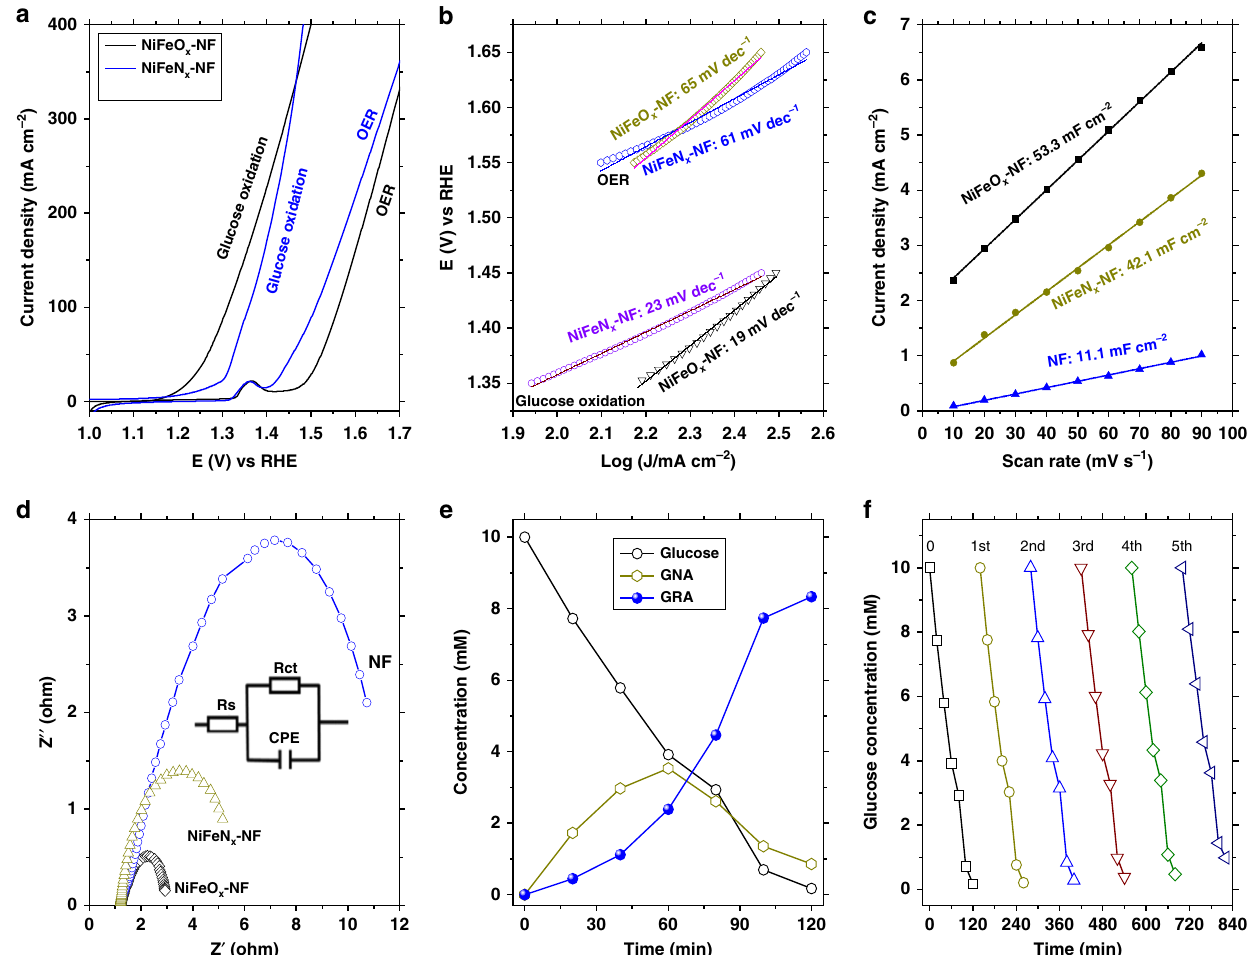
Fig. 4 Anodic glucose oxidation. a LSV pro fi les of the NiFeO x -NF and NiFeN x -NF catalysts for glucose oxidation and OER (scan rate of 5 mV s − 1 ; electrolyte: 1 M KOH; glucose concentration 100 mM). b Corresponding Tafel plots. c Capacitive current densities of different electrodes for glucose oxidation as a function of scan rate. d Nyquist plots (taken at 1.3 V vs. RHE) of different electrodes for glucose oxidation. e Concentration of glucose and oxidation products as a function of time for chronoamperometric tests at 1.30 V vs. RHE. f Glucose concentration changes in fi ve successive